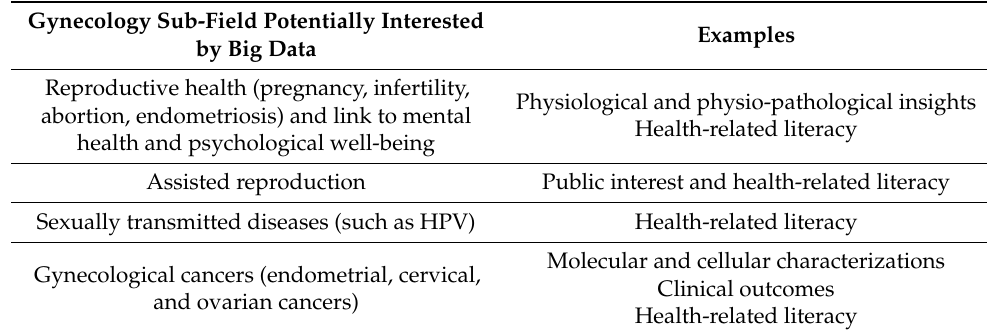
Table 4. Aspects and sub-fields of gynecology that can benefit from the use of big data.